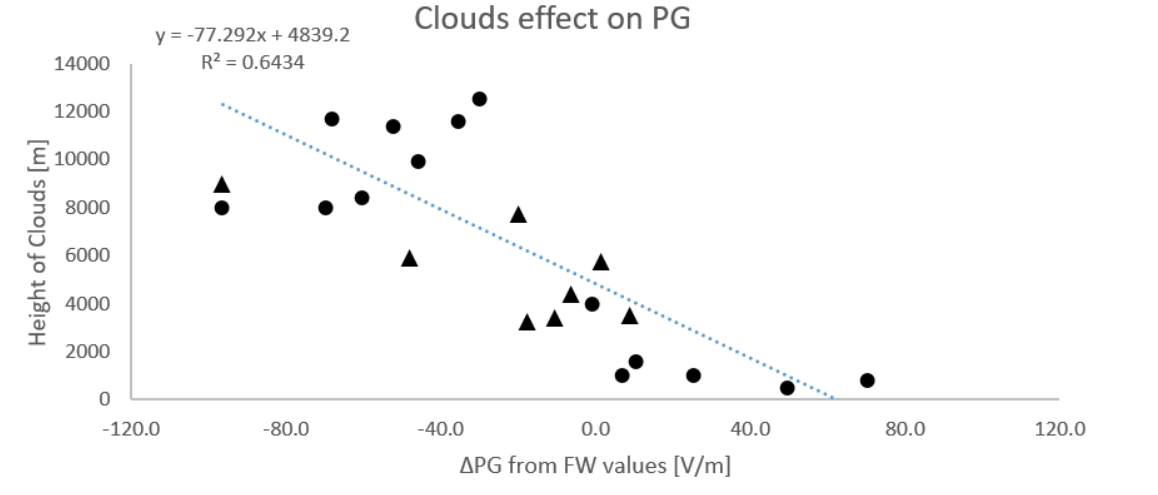
Figure 2. The height of clouds and their effect on the measured ground level PG. Circles are single layer of clouds while the triangles are a superposition of two or three types of clouds and are the average height. (for example, a presence of a ~10 km high cirrus cloud together with a ~1500 m stratus layer is indicated as a single combined height of 5750 m).